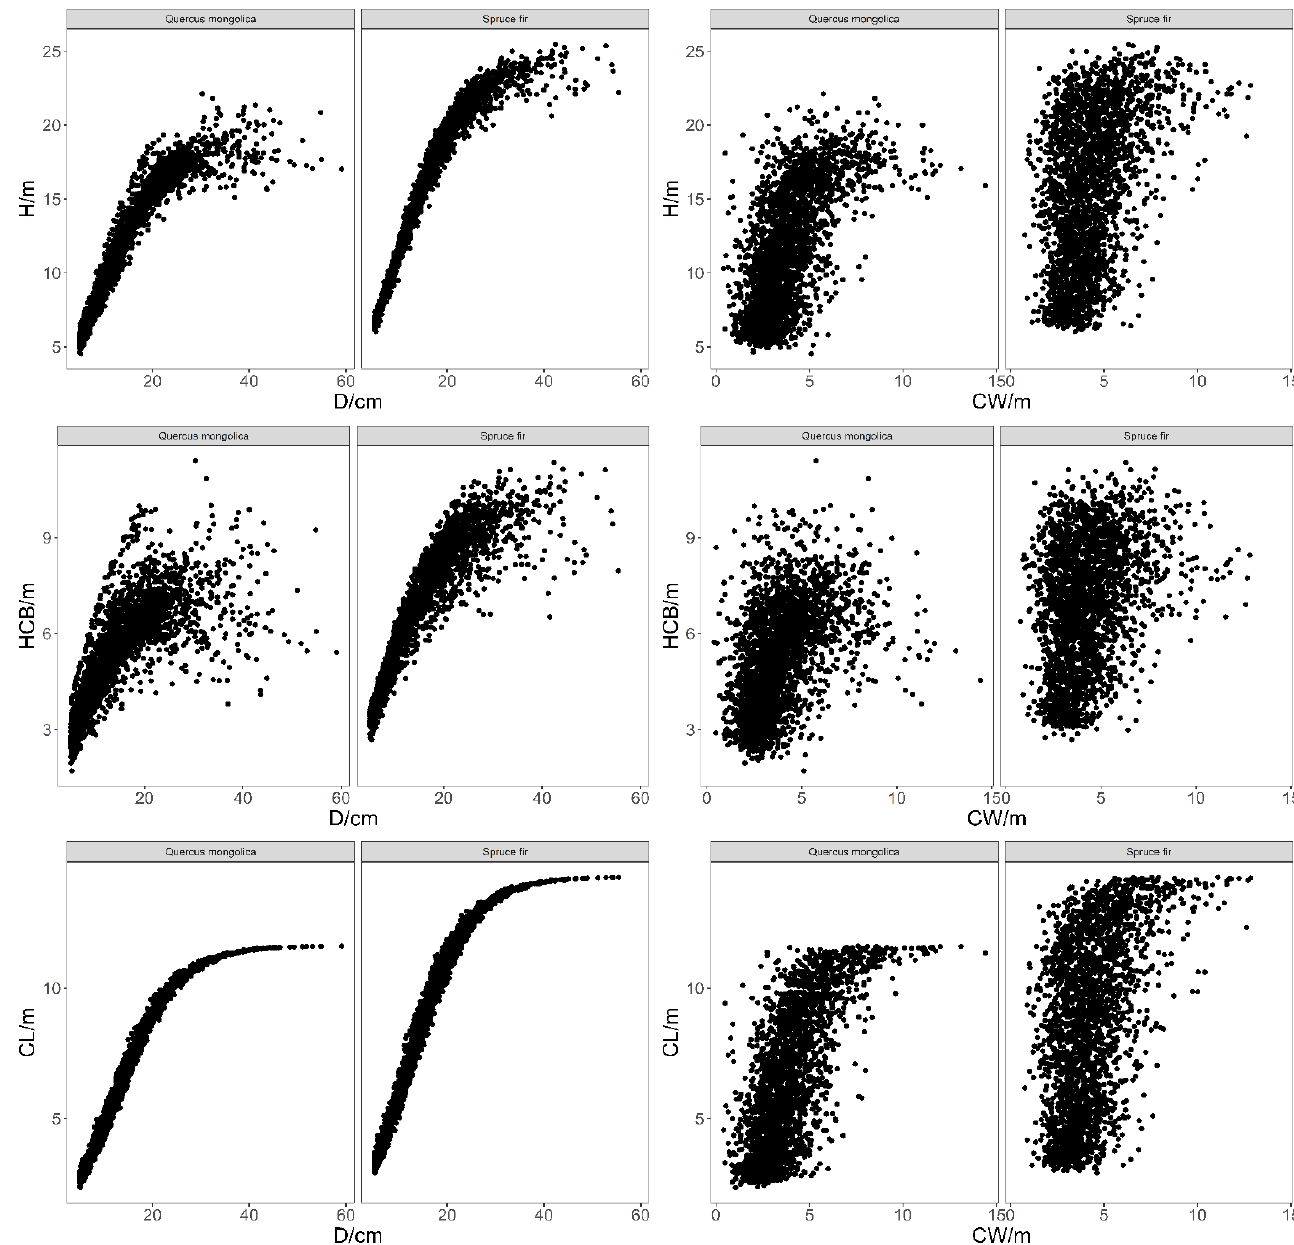
Figure 8. Predicted values of dependent variables using Equation (20) ( D : diameter at breast height (cm); CW : crown width (m)).